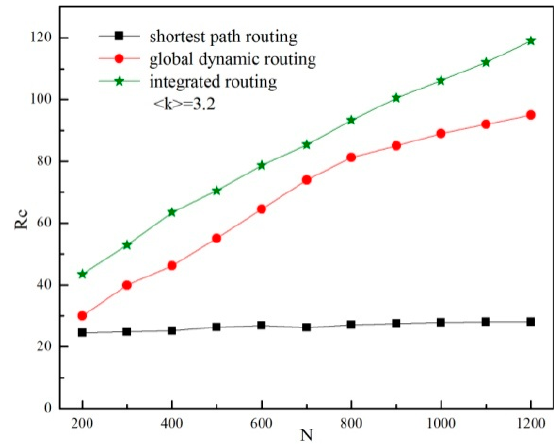
Figure 16. The critical packet generation rate Rc vs. network size N with the same average degree <k> = 3.2 (Beijing power communication network average degree) under the three routing strategies.